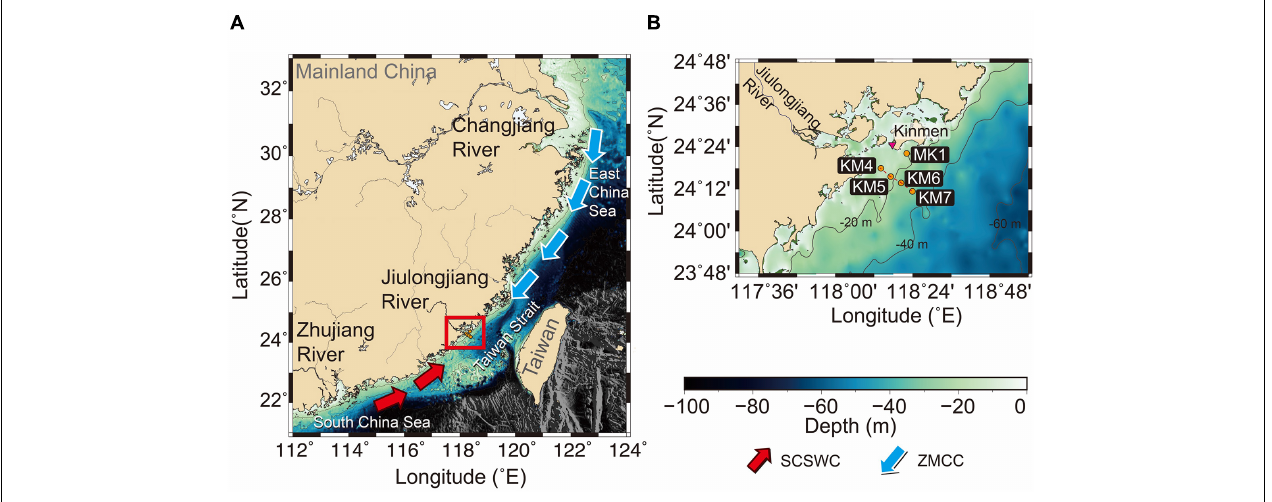
FIGURE 1 | (A) The map showing the Taiwan Strait that links the South China Sea and East China Sea. The red box indicates the location of the study area (Xiamen Bay). Red arrows represent the direction of SCSWC, blue arrows roughly represent the direction of the ZMCC. (B) Enlarged map of the red box showing the fixed sampling station at MK1 and transect stations KM4 ∼ KM7 by orange circles. The bright purple triangle showing the Kinmen Weather